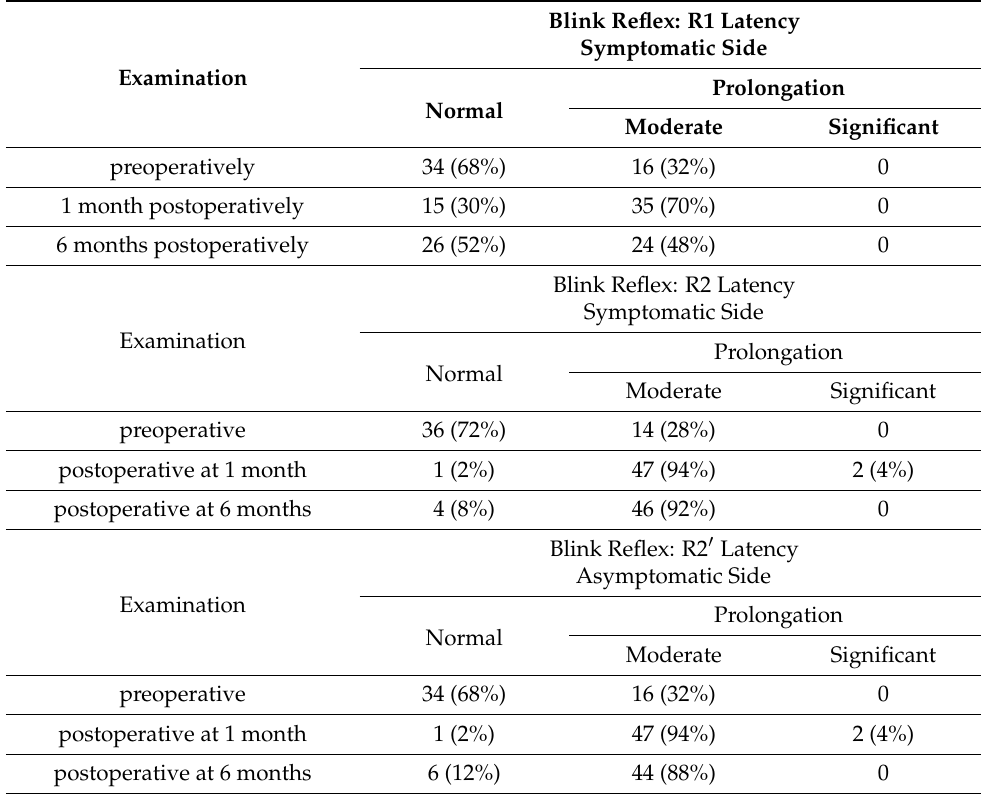
Table 3. Blink reflex: assessment of R1, R2 and R2 (cid:48)